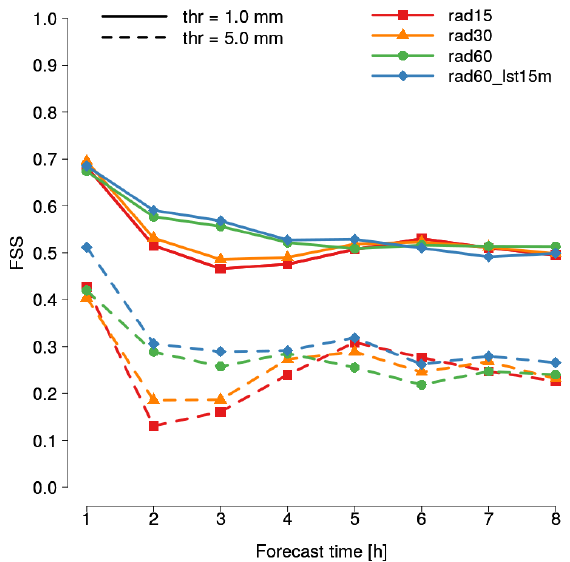
Figure 8. As in Fig. 6 but considering experiments rad15 (red), rad30 (orange), rad60 (green) and rad60_lst15 (blue).